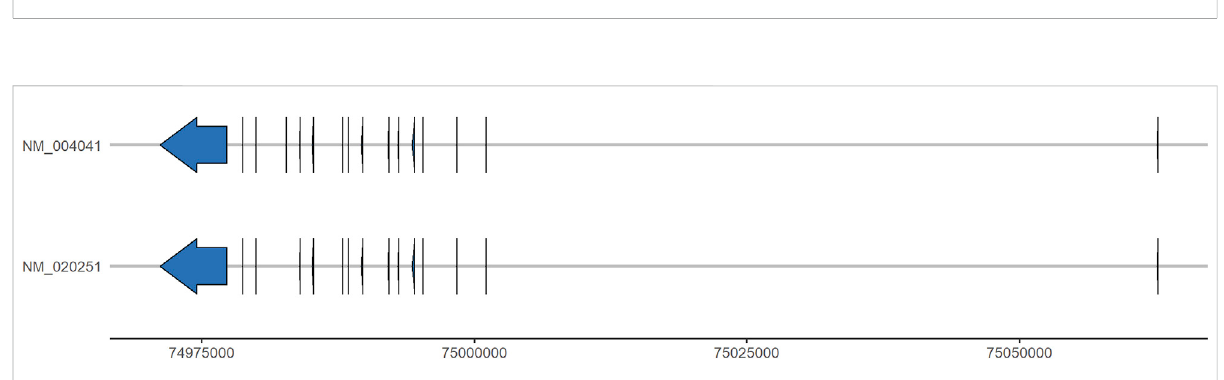
FIGURE 2 ARRB1 transcript isoforms. Graphical representations of the two ARRB1 transcript isoforms along chromosome 11 (genomic position, x -axis). Exons and 5 ′ - and 3 ′ -untranslated regions are represented by vertical lines and arrows. Intronic sequences are represented by the intervening horizontal lines. Data were obtained from NCBI Genome Data Viewer, assembly GRCh37. p13 (accessed 15 August